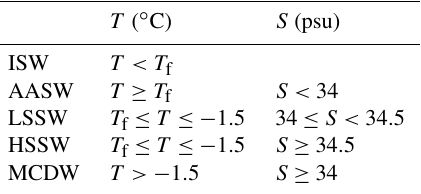
Table 2. Potential temperature ( T ) and salinity ( S ) ranges used to categorise water masses in ice-shelf cavities in Fig. 10. T f is the surface freezing point as in Fig. 4. All acronyms are the same as in Fig. 4.